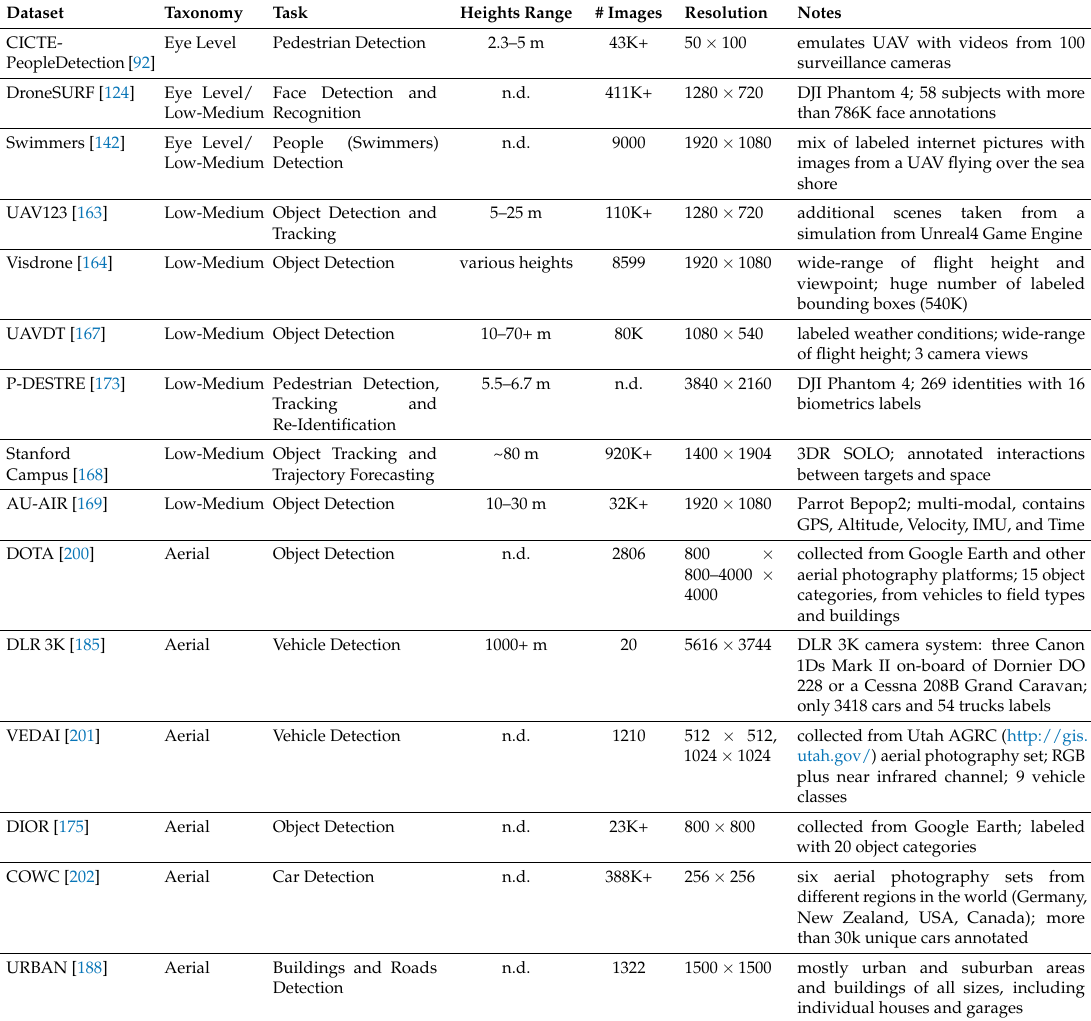
Table 2. A summary of relevant datasets for 2D object detection from UAV and aerial images. n.d. stands for no data